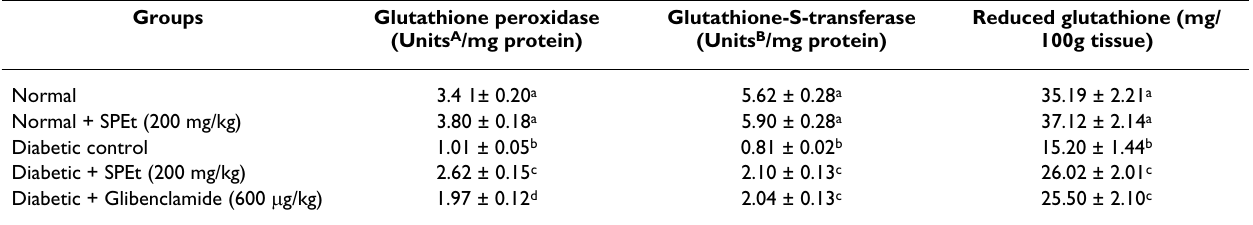
Table 4: Changes in activities of glutathione peroxidase, glutathione-S-transferase and the levels of reduced glutathione in brain of normal and experimental rats